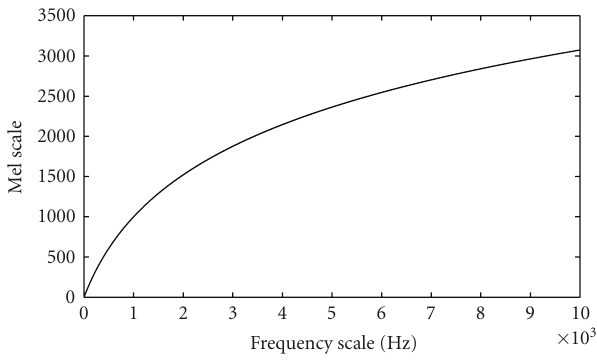
Figure 3: Relation between Hz and MEL